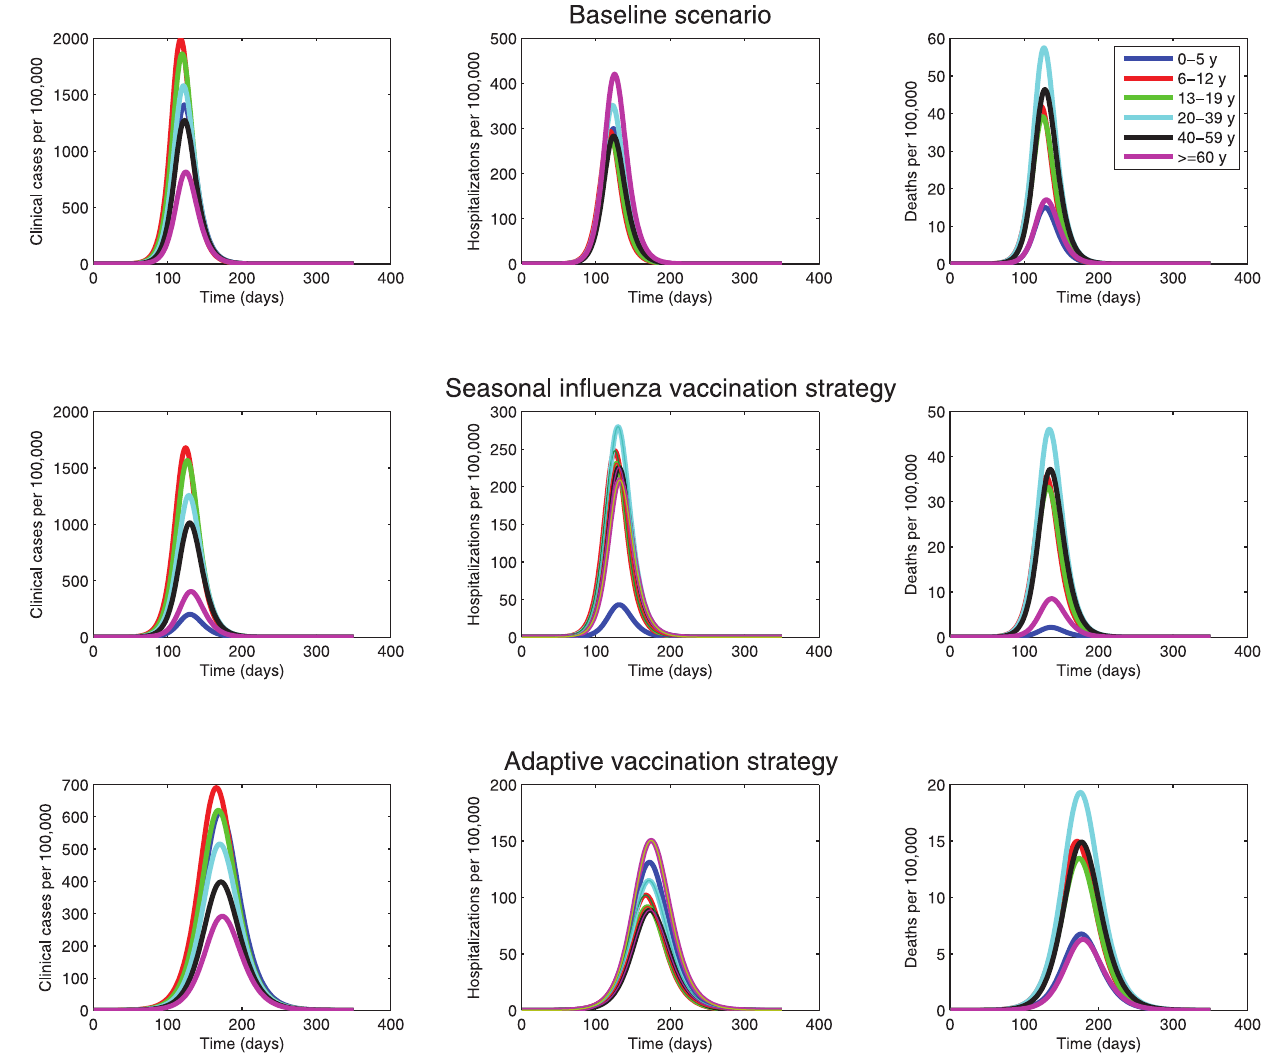
Figure 3. Age-specific incidence curves of clinical cases, hospitalizations and deaths in the context of the 2009 S-OIV outbreak in Mexico. We considered a baseline situation with R 0 =1.6 where no vaccine is used (top panel), a seasonal vaccination strategy (middle panel) where priority groups for vaccination are young children and seniors, as for seasonal influenza, and an adaptive vaccination strategy (bottom panel) where vaccine is allocated according to data on age-specific rates of mortality. The vaccination coverage is 20% and vaccination is initiated 25 days after the epidemic onset when an epidemiologic alert was issued in Mexico.